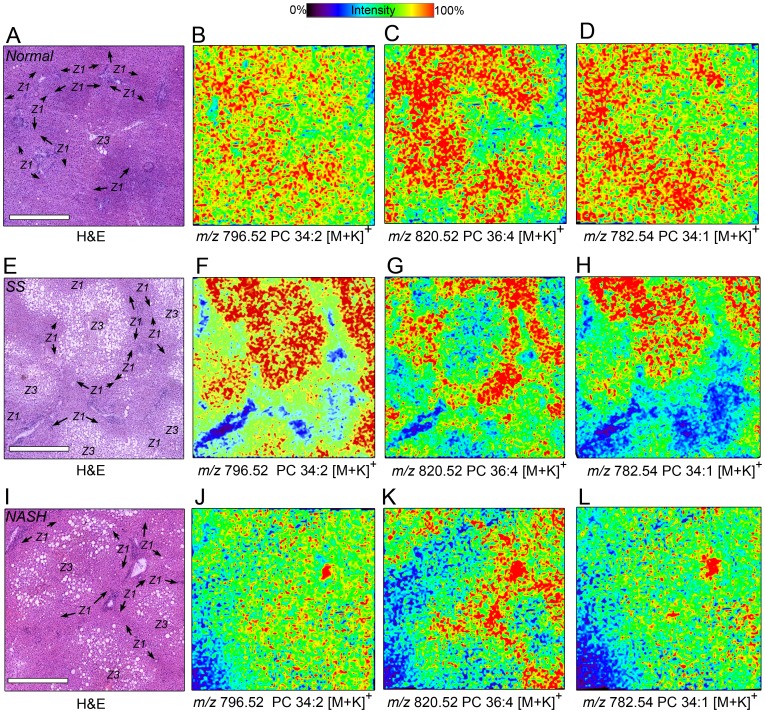
Lipid MALDI ion images reveal differences in PC zonation across the liver lobule.Representative MALDI IMS images of selected liver specimens obtained from obese subjects with normal liver histology (A–D), SS (E–H), and NASH (I–L). (A, E, I) Photomicrographs of H&E stained sections from each specimen (far left column) indicate lobular zones (zone 1 - Z1; zone 3 - Z3). Comparison of selected PCs by disease state: MALDI images of m/z 796.52 PC 34∶2 [M+K]+ in obese normal (B), SS (F), and NASH (J) specimens. MALDI images of m/z 820.52 PC 36∶4 [M+K]+ in obese normal (C), SS (G), and NASH (K) specimens. MALDI image of m/z 782.54 PC 34∶1 [M+K]+ in obese normal (D), SS (H), and NASH (L) specimens. Ion intensity color scale for all ion images is shown at the top of panels B and C. Scale bar = 500 µm.